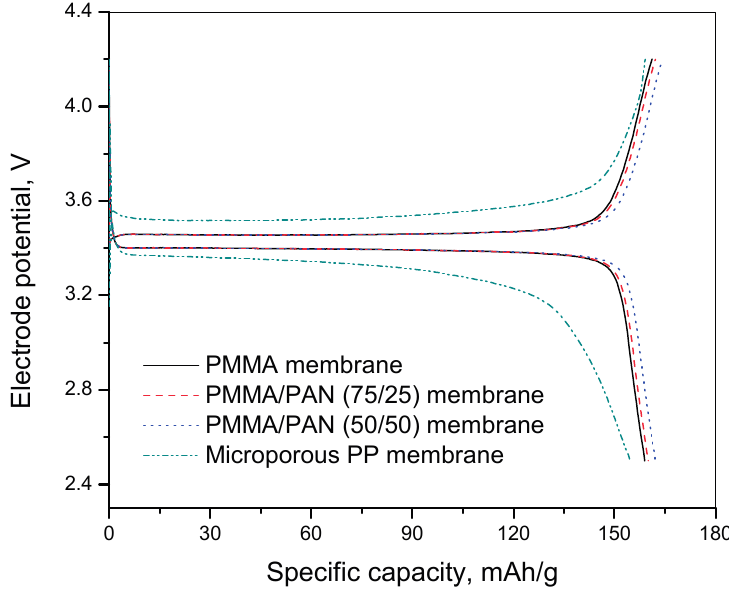
Figure 6. First-cycle charge-discharge curves of Li/LiFePO 4 cells containing PMMA membrane, PMMA/PAN (75/25) membrane, PMMA/PAN (50/50) membrane, and microporous PP membrane at 0.2